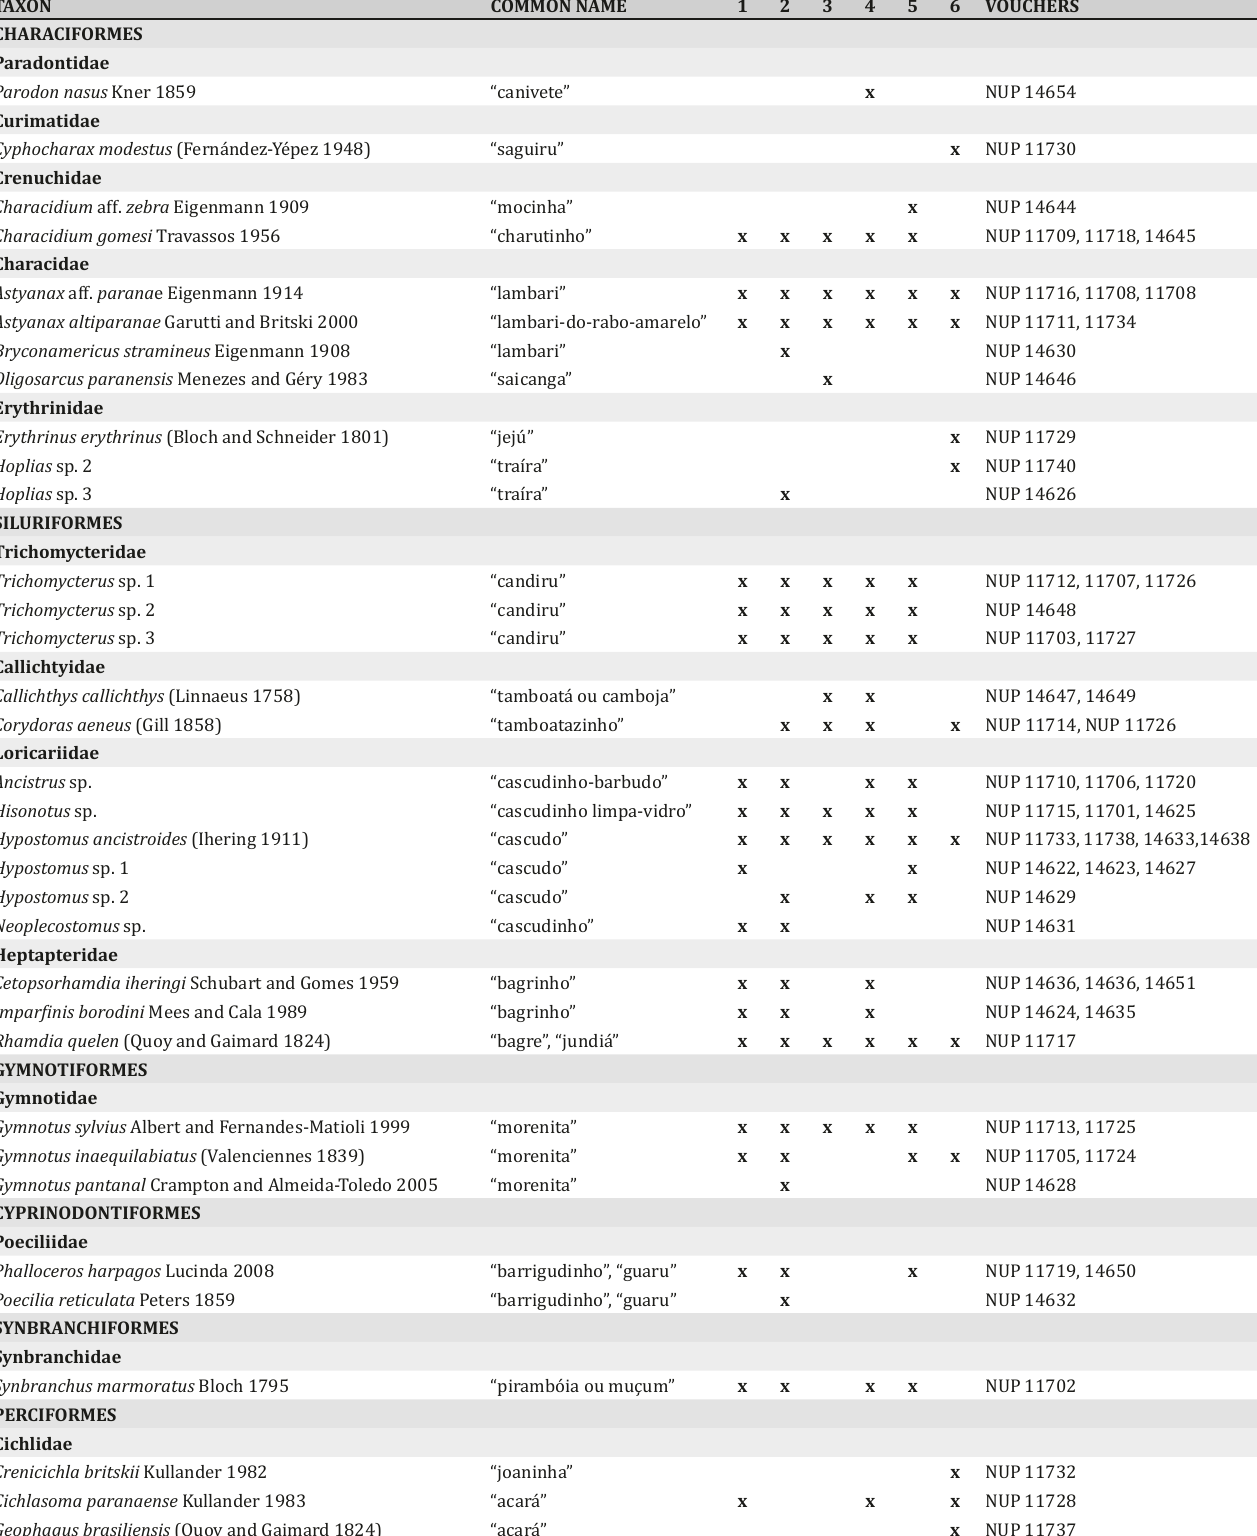
Table 2. et al. List of fish and their respective occurrences at sampling reaches of the Rebio das Perobas, Ivaí and Piquiri River basin, state of Paraná, Brazil. Systematic positions were based on Reis